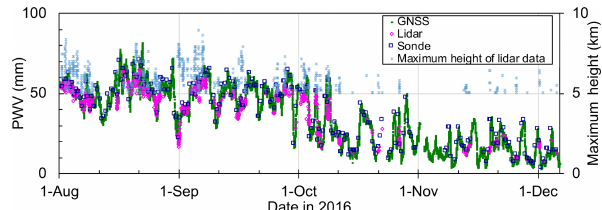
Figure 12. Temporal variations in PWV obtained with lidar (ma- genta diamonds), GNSS (green dots), and radiosonde (blue squares) from 2 August to 6 December 2016 over Tsukuba. Data with mea- surement uncertainties of less than 10% that were obtained when the maximum MRL measurement height exceeded 5km (light blue asterisks) are